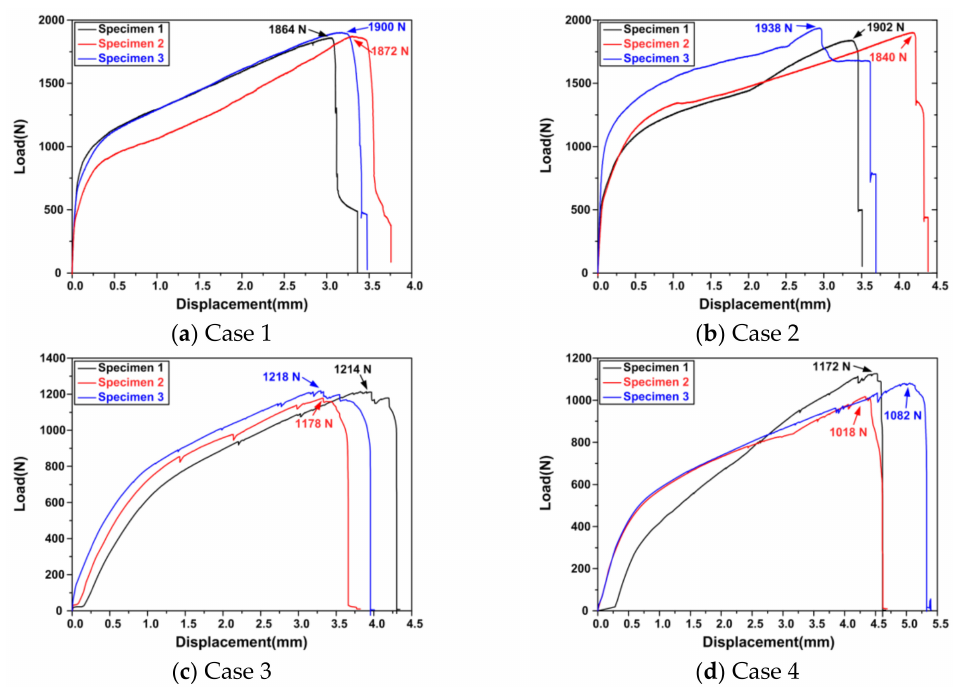
Figure 6. Load–displacement curves of the hole-clinched joints obtained by the cross-tension